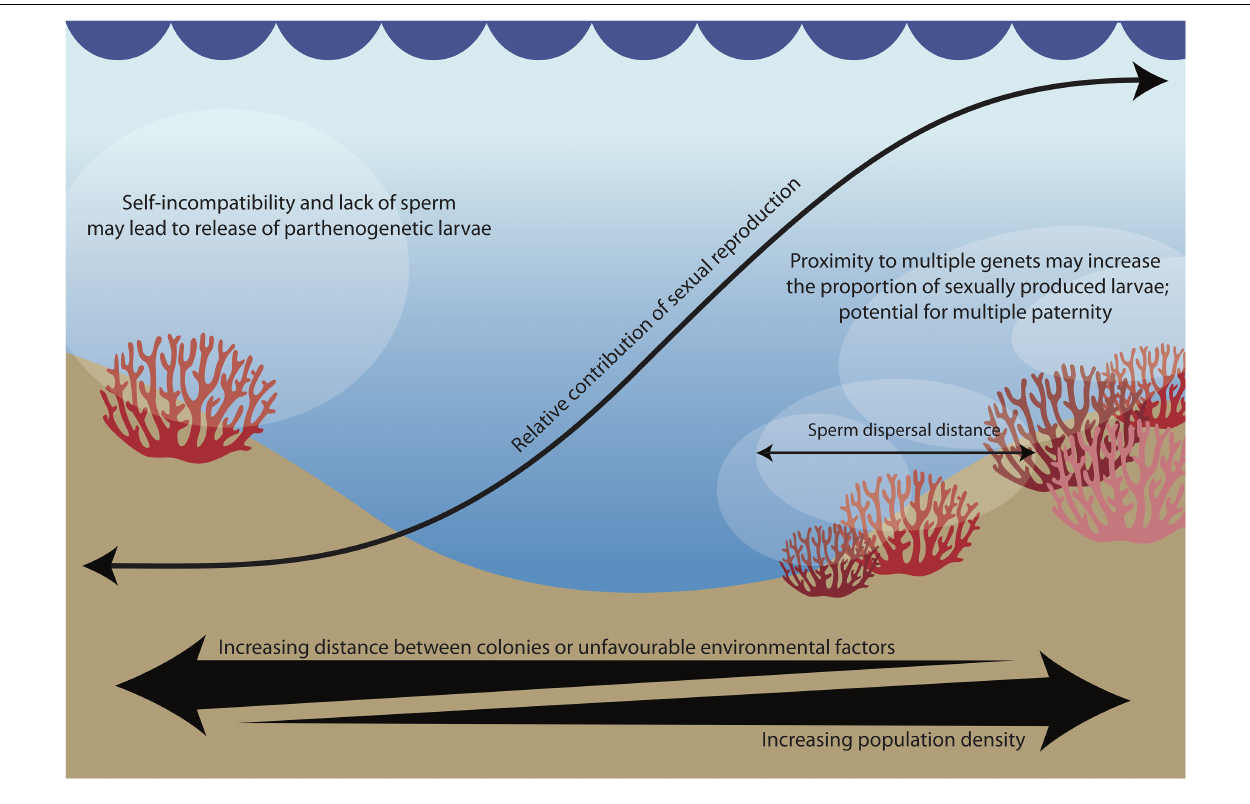
FIGURE 3 | According to our hypothesis, sperm availability increases the proportion of sexually derived offspring and may result in multiple paternity, while mate scarcity leads to the production of parthenogenetic offspring.